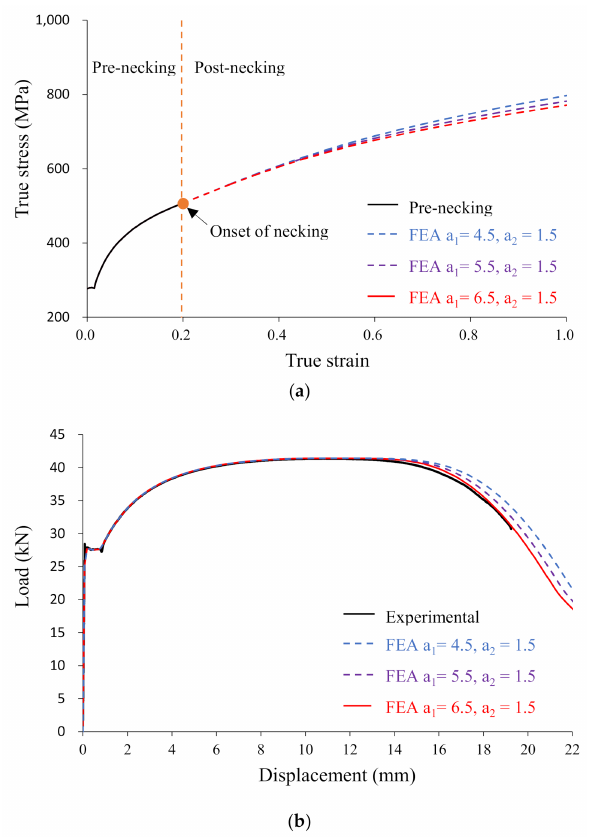
Figure 5. ( a ) True stress–strain curves; ( b ) Calibration outcomes of Specimen